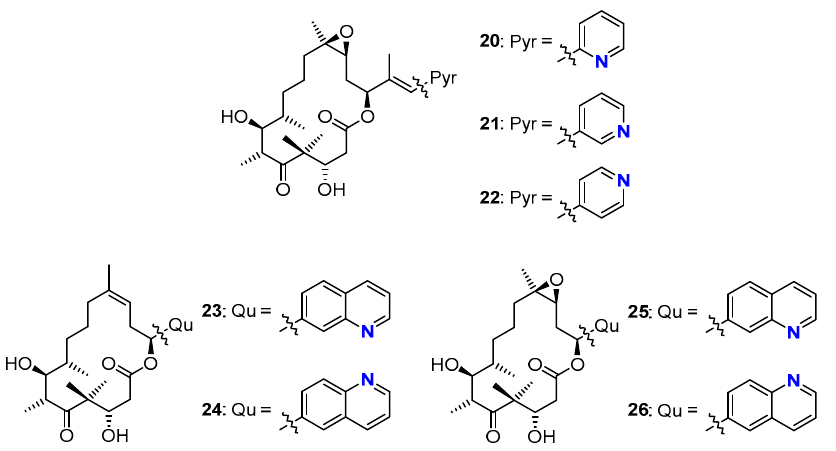
Figure 4. Molecular structures of previously reported pyridine-[36] and quinoline-based [25] epothilone B analogs. Table 2. Binding constants of azathilones for stabilized microtubules 1 .